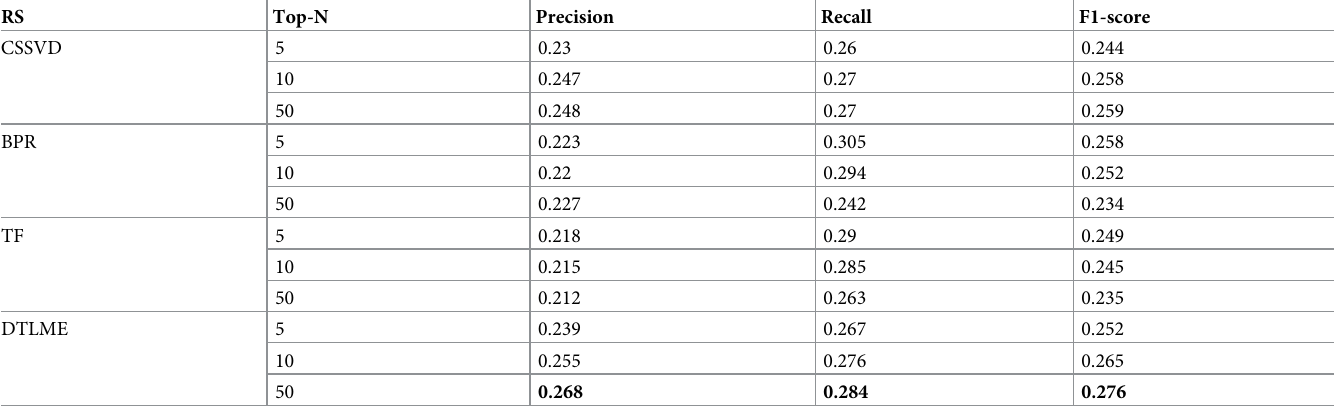
Table 3. Performance comparison of proposed model with baseline recommendation techniques.